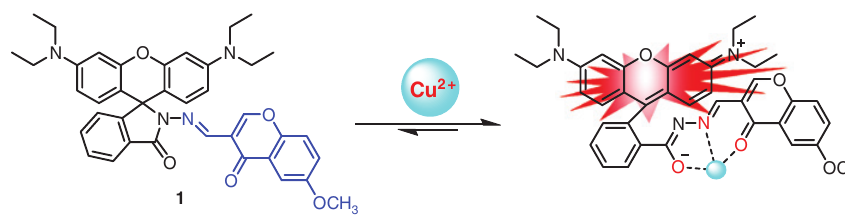
Figure 4: Recognition mechanism of probe 1 with Cu 2 + .